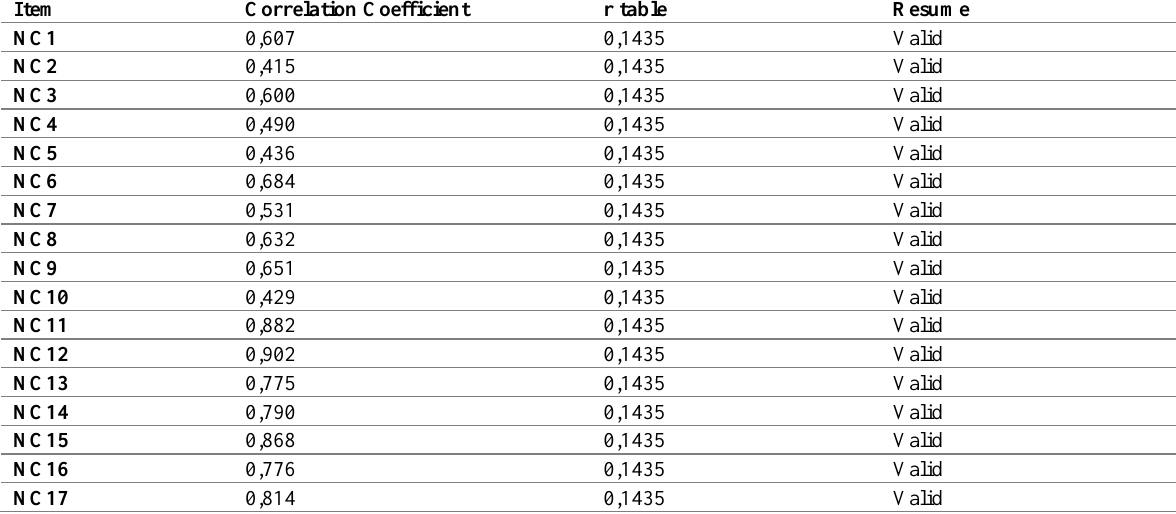
Table 2: Internationalization Validity